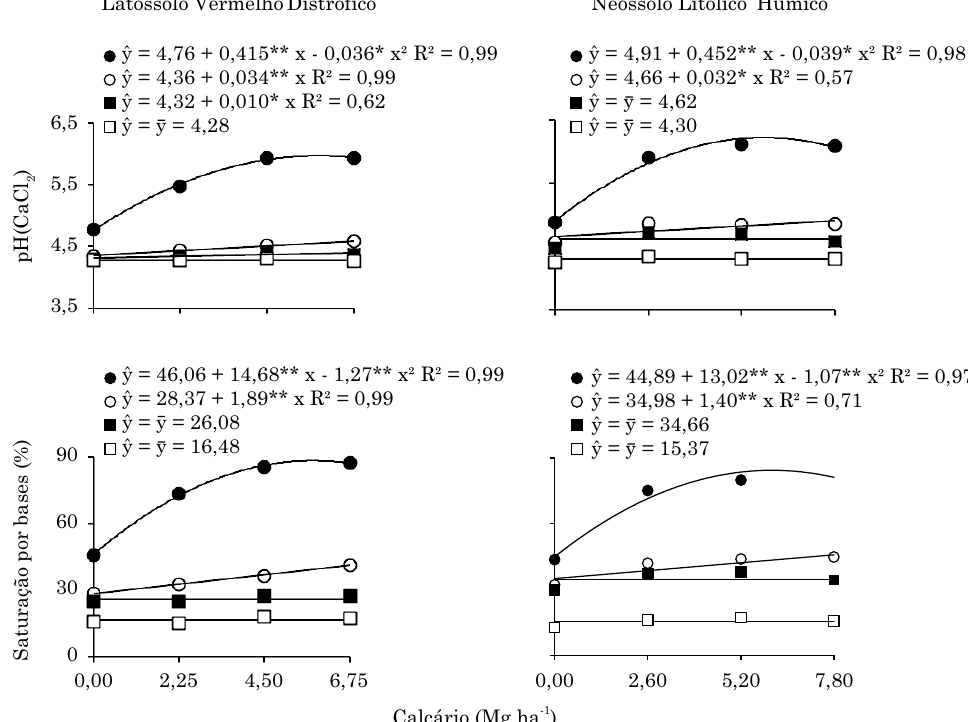
Figura 2. Alterações no pH em CaCl 2 e na saturação por bases do Latossolo Vermelho Distrófico e do Neossolo Litólico Húmico, nas profundidades de 0,00-0,05 m (●); 0,05-0,10 m (○); 0,10-0,20 m (■) e 0,20-0,40 m (□), considerando as doses de calcário aplicadas na superfície em sistema plantio direto. Os valores são médias de duas fontes de calcário (dolomítico e calcítico) e duas faixas de prnt (B e d). A calagem foi realizada em agosto de 2010, e as amostras de solo foram coletadas em agosto de 2011. * e **: significativo a 5 e 1 %,